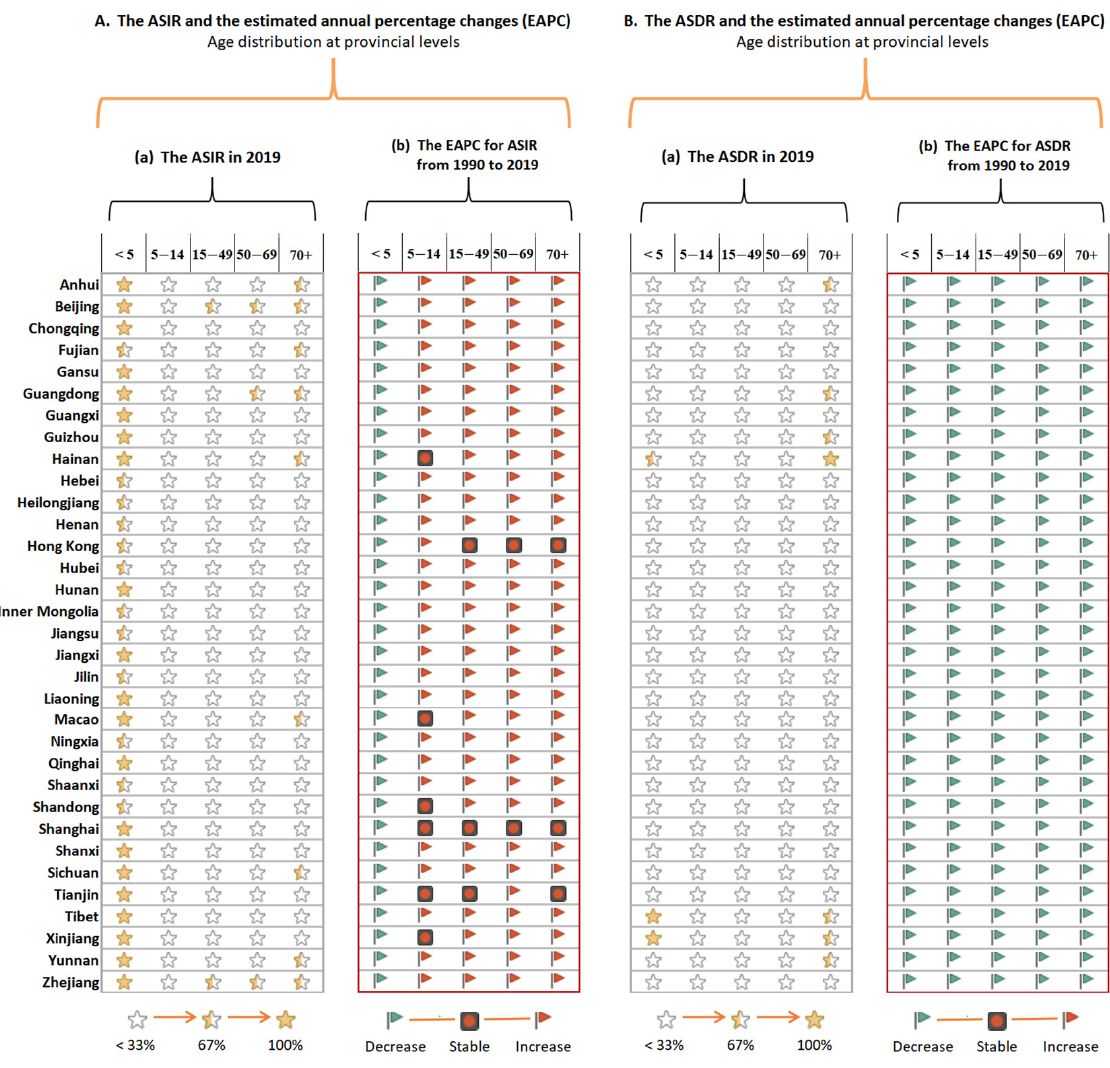
Figure 5. The age-standardized incidence rate and DALYs rate of overall nutritional deficiencies in 2019 and their estimated annual percentage changes (EAPC) from 1990 to 2019 by ages at provincial levels of China.